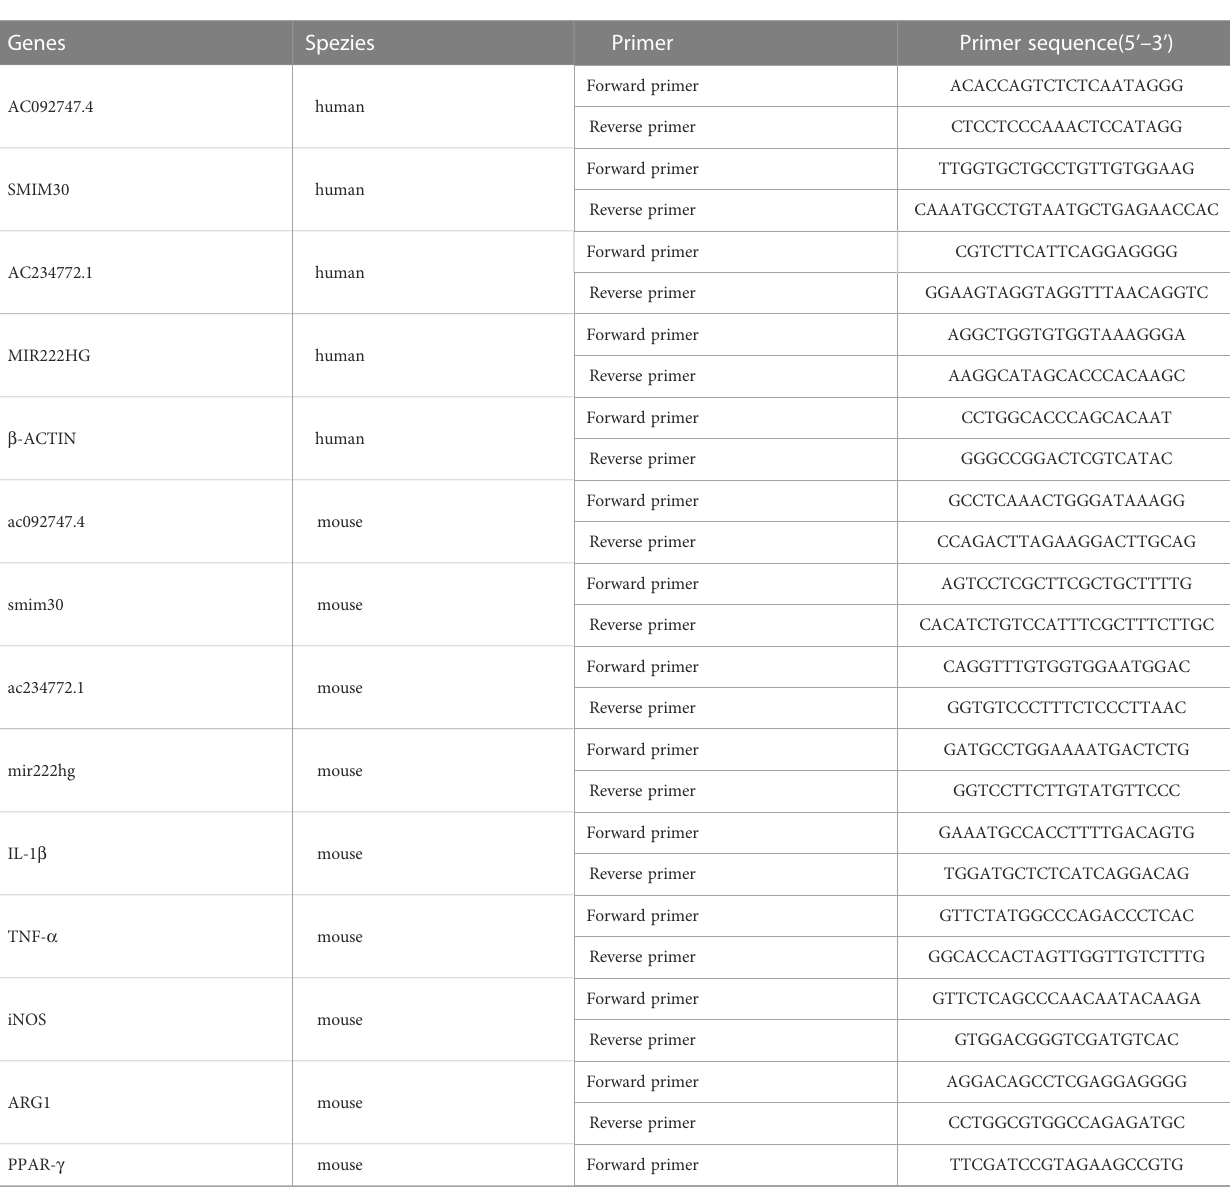
TABLE 3 List of primers used for qRT-PCR analysis.